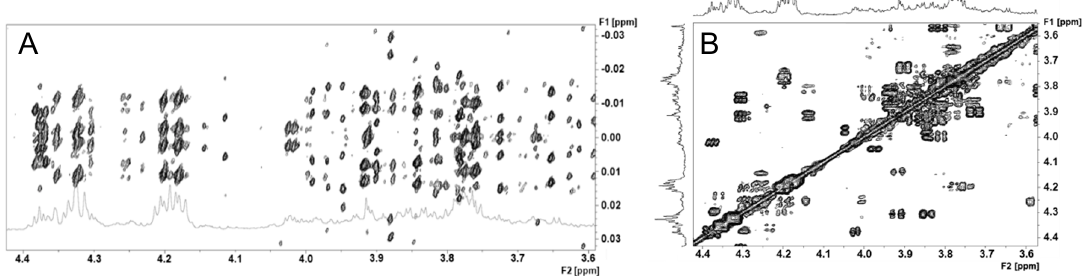
Figure 2. JRES 1 H ( A ) and correlation spectroscopy (COSY) 1 H- 1 H ( B ) NMR spectra in the 3.6 to 4.4 ppm region of the Dreissena polymorpha whole body. A high number of complex peak clusters with numerous correlated resonances is superposed in this region, making it difficult to interpret.